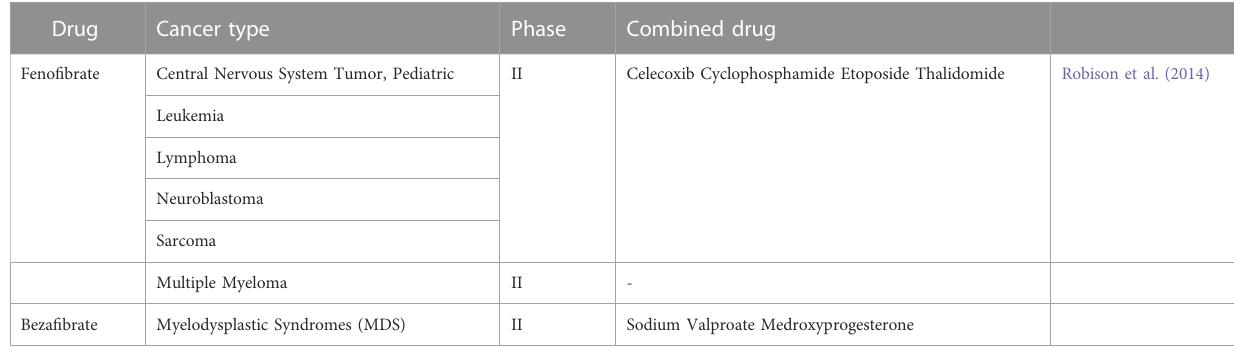
TABLE 3 Clinical trials of fi brate in